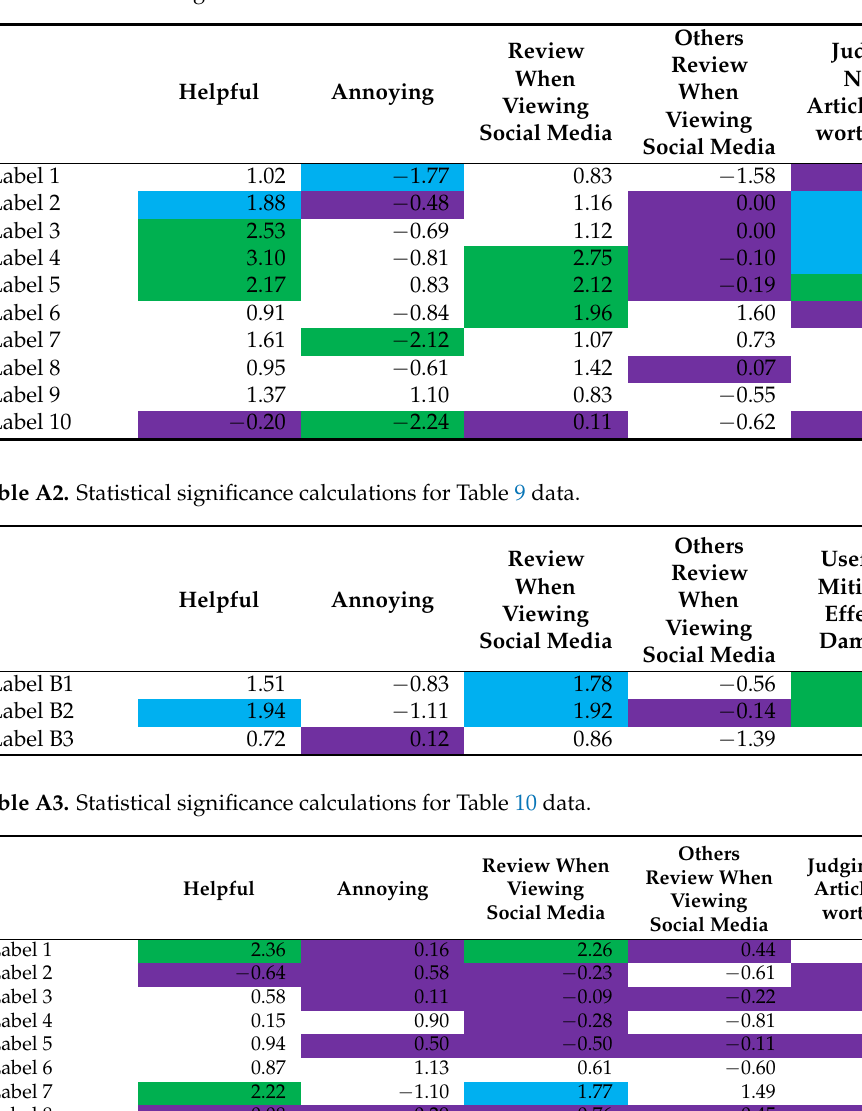
Table A1. Statistical significance calculations for Table 8 data.